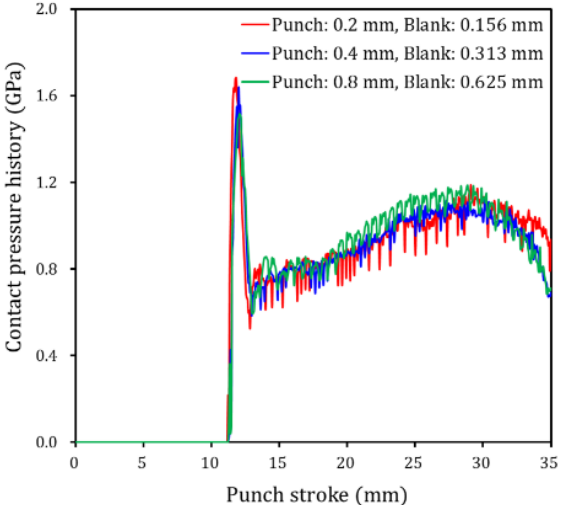
Figure 6. Contact pressure history comparison at a node on the punch radius where the highest contact pressure occurs to evaluate contact characteristics according to element sizes.